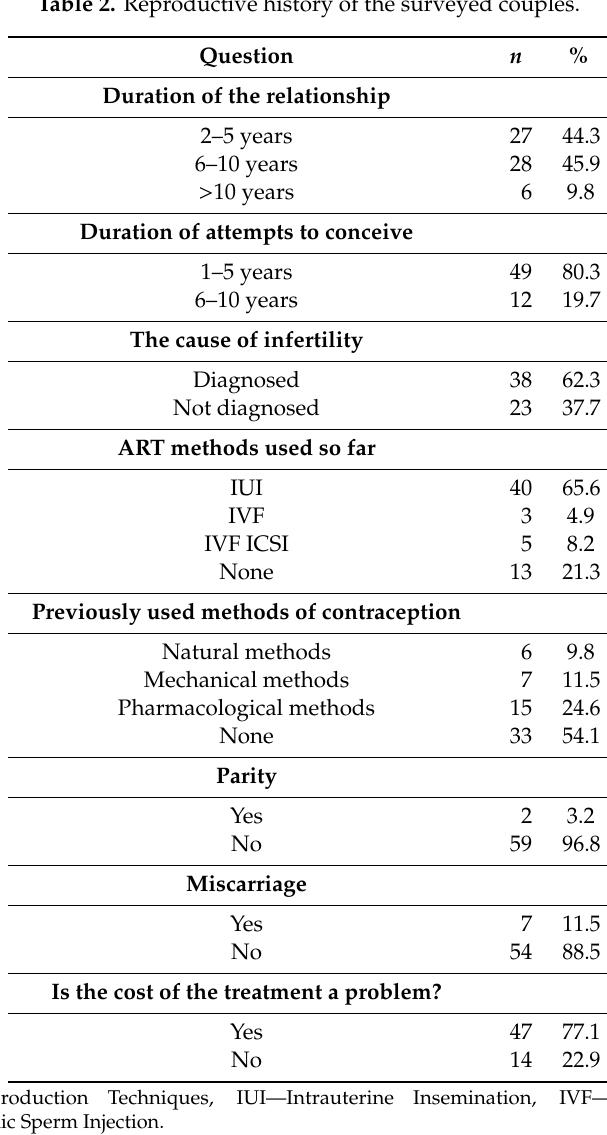
Table 2. Reproductive history of the surveyed